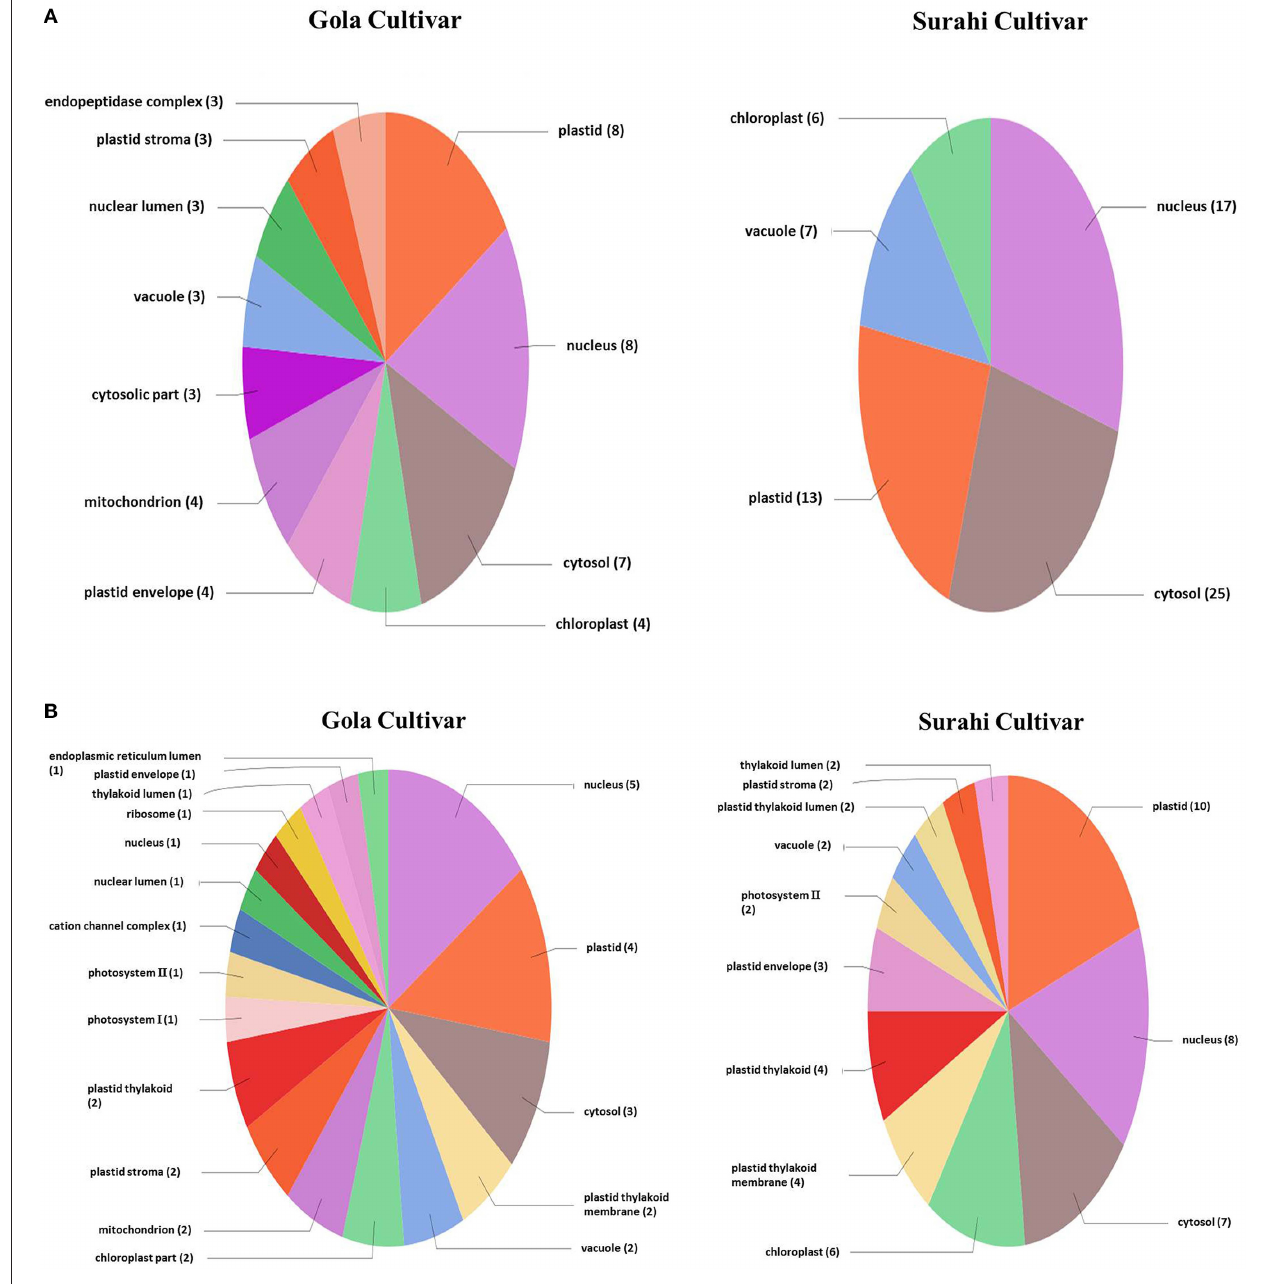
FIGURE 3 | Functional annotation of the upregulated (A) and downregulated (B) ESTs in cellular components of guava under drought